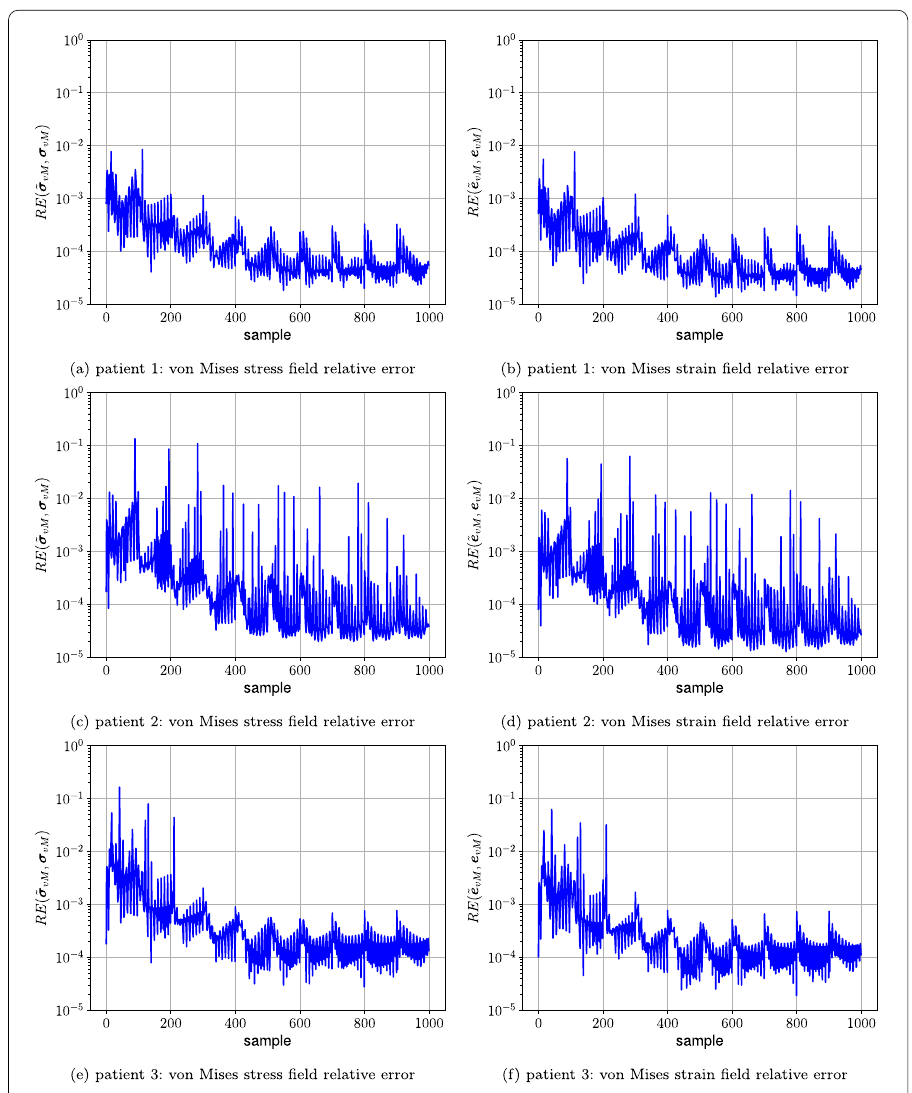
Fig. 12 Relative l2-error of the DHROM in terms of the von Mises stress and von Mises strain fields in the aortic wall. The test grid corresponds to a full factorial and equidistant 10 × 10 × 10 grid in the parameter domain. The results state individual simulations showing errors above 1%, while the majority ( > 98%) of simulations shows errors below